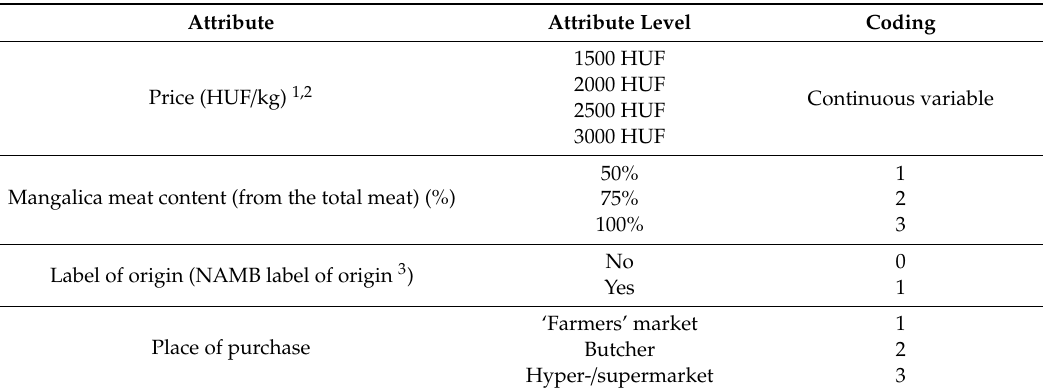
Table 1. Attributes, their levels, and their coding.